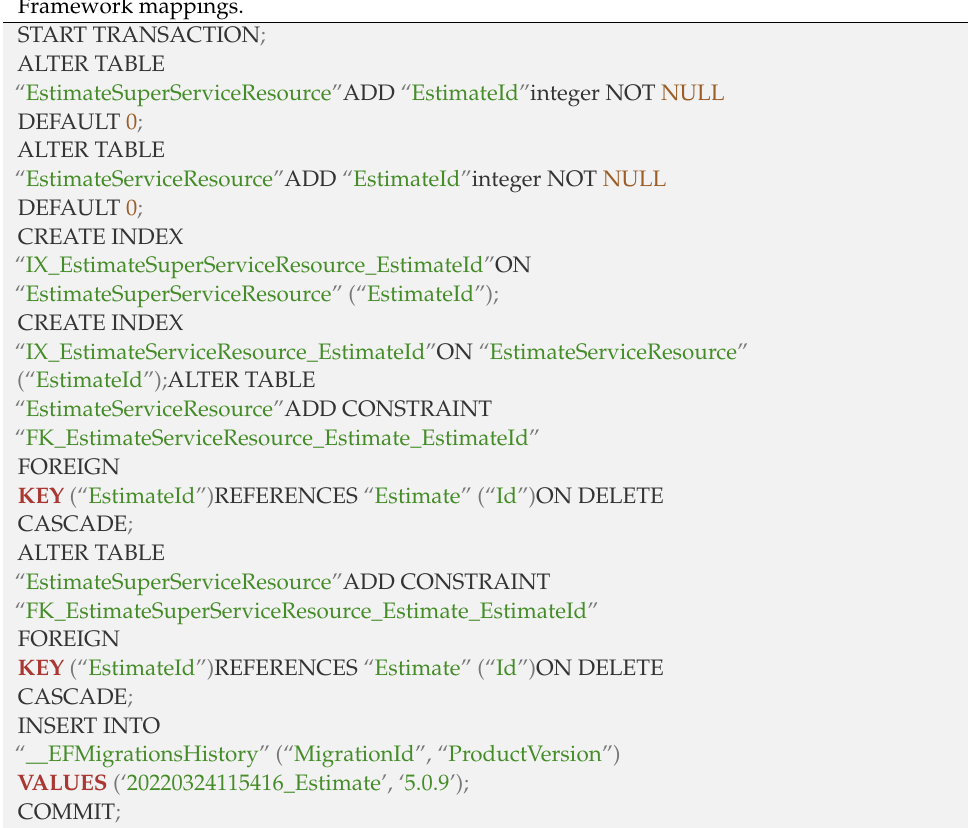
Algorithm 3: Solving problems at the database level and incomplete iterations through Entity Framework